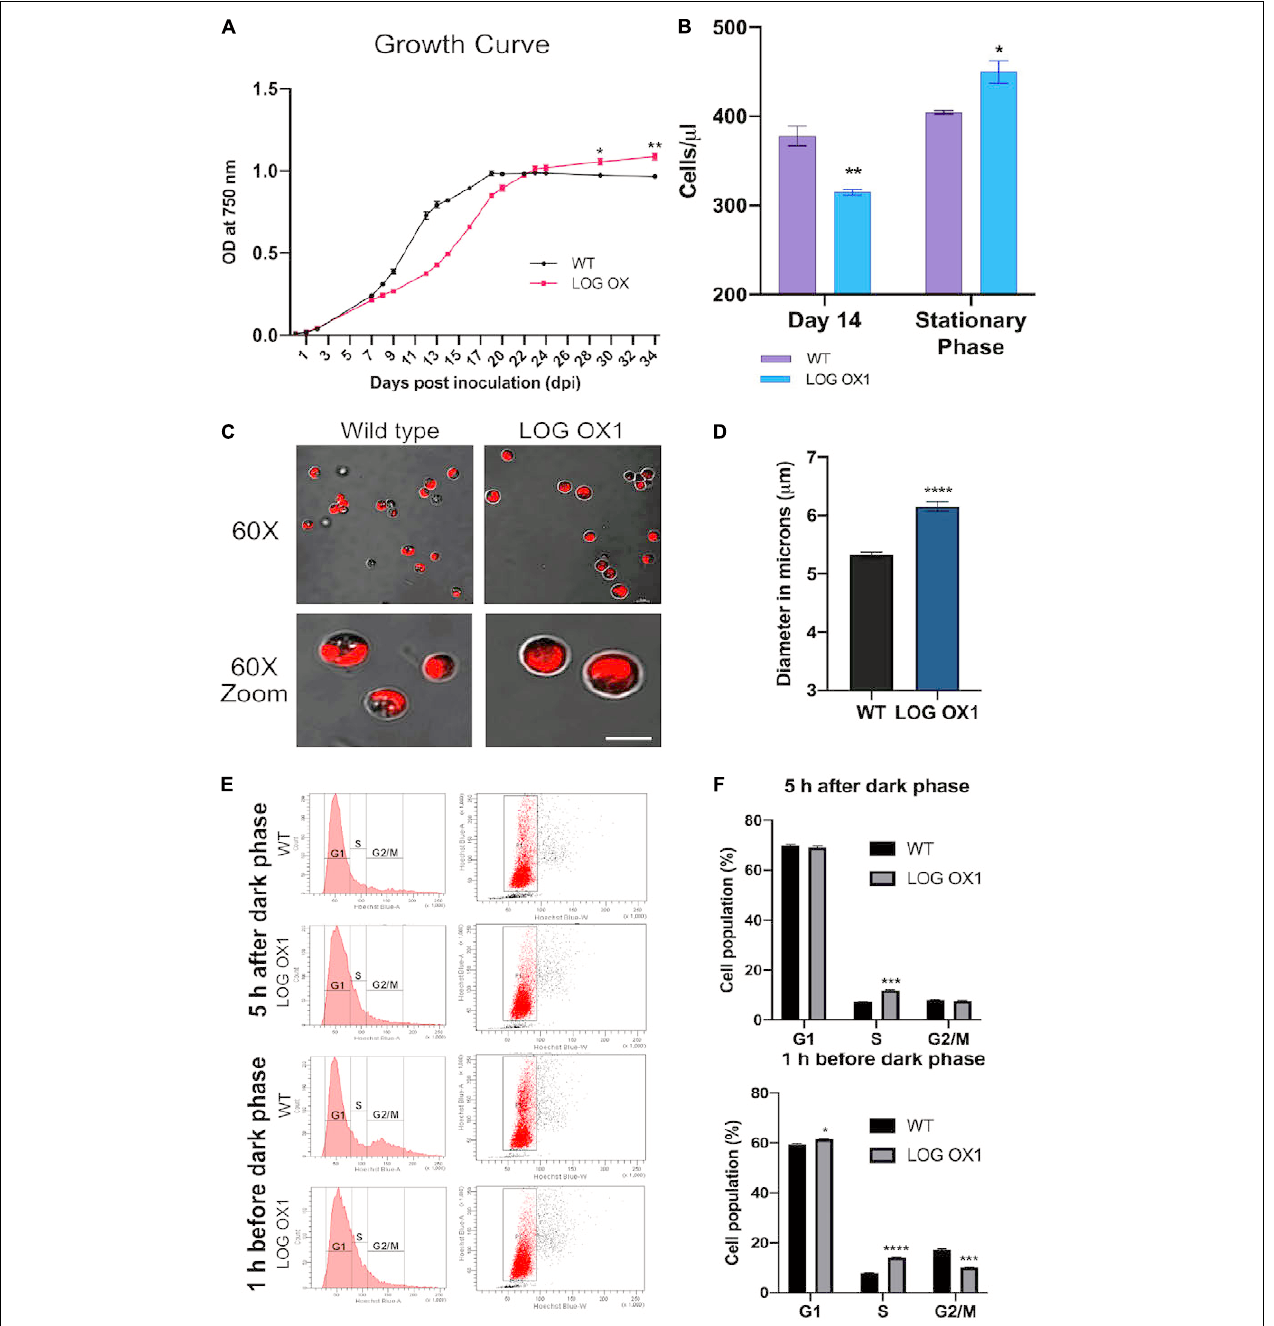
FIGURE 5 | Detailed characterization of the LOG OX1 phenotype. (A) Spectrophotometric values of optical density (OD) at 750 nm was plotted versus time (dpi; days post inoculation) to determine the growth kinetics of LOG OX vs. WT, bars indicate ± SE ( n = 3). (B) Absolute cell counts of LOG OX1 and WT algae to determine cell number at 14 dpi and stationary phase (19 dpi; WT, 29 dpi; LOG OX1, bars indicate ± SE, n = 3). (C) Comparison of cells of wild type and LOG OX1 morphology at 20 dpi, visually the cells of LOG OX are more prominent in size. Bar = 5 µ m (D) Comparison of cell diameter in wild type and LOG OX1 cells at 20 dpi, bars indicate ± SE ( n = 3, with at least 50 cells in each replicate). (E) Cell cycle analysis for 14 dpi culture from 5 h after dark phase and 1 h before dark phase of wild type and LOG OX1 cells. Cells were stained with DAPI and monitored using a flow cytometer. (F) Cell cycle phase distribution in terms of percentage in WT and LOG OX1 for samples taken from 5 h after dark phase and 1 h before dark phase 14 dpi cultures; bars indicate ± SE ( n = 3). For all graphs, data significant at **** P ≤ 0.0001, *** P ≤ 0.001, ** P ≤ 0.01, and * P ≤ 0.05 compared with the wild type using Student’s t -test.